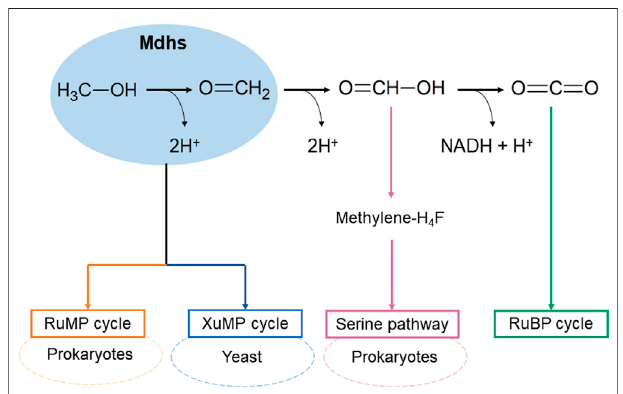
FIGURE 1 | Natural methane and methanol utilization pathways in methylotrophs.